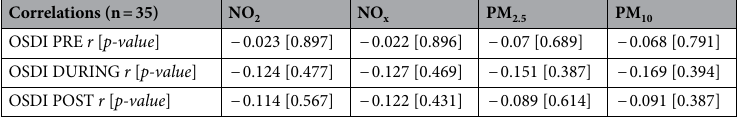
Table 2. Correlations dry eye symptoms (OSDI questionnaire scores) and air